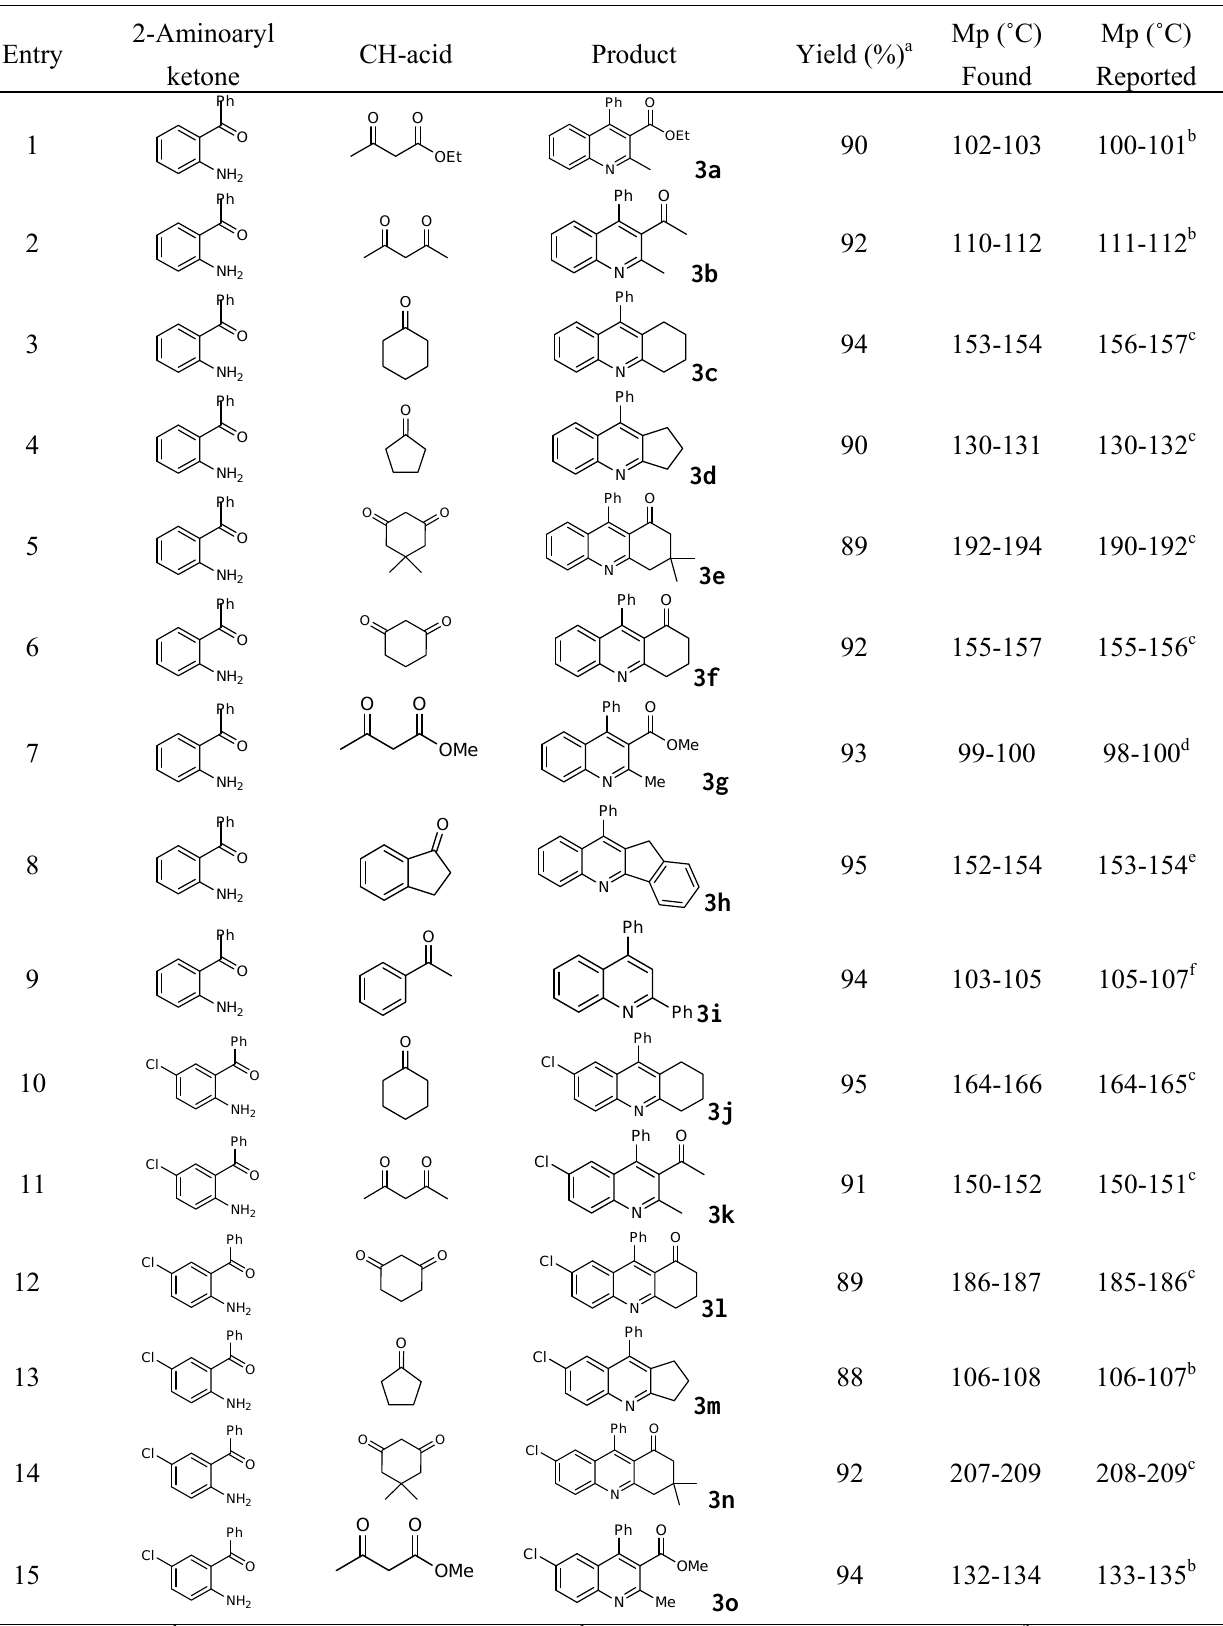
Table 2. Synthesis of quinolines in the presence of H conditions at 80 ˚ C in 2